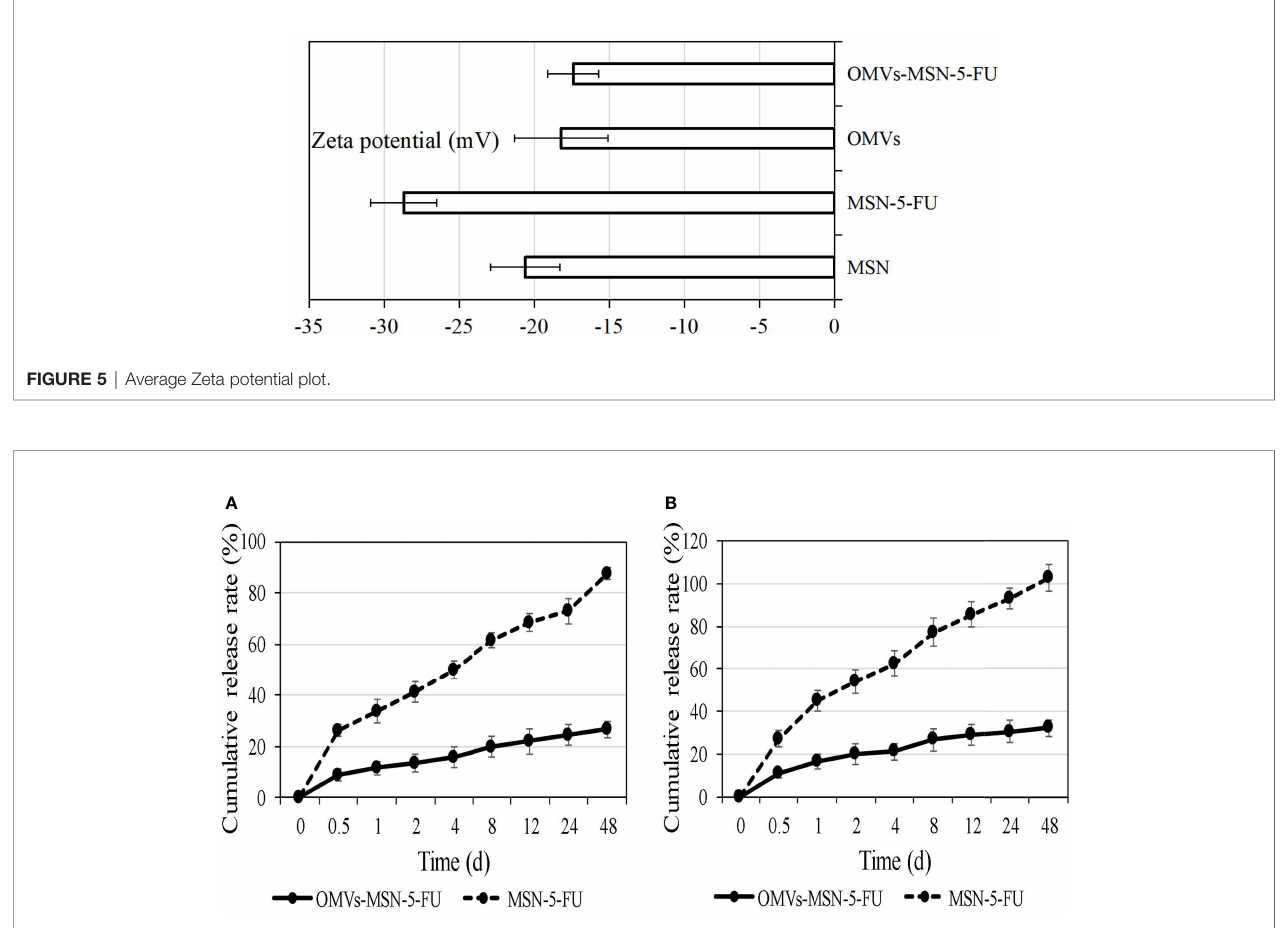
FIGURE 6 | In vitro cumulative release rate curve of the nano-drug delivery systems. (A) was the cumulative release curve in arti fi cial gastric juice; (B) was the cumulative release curve in arti fi cial intestinal